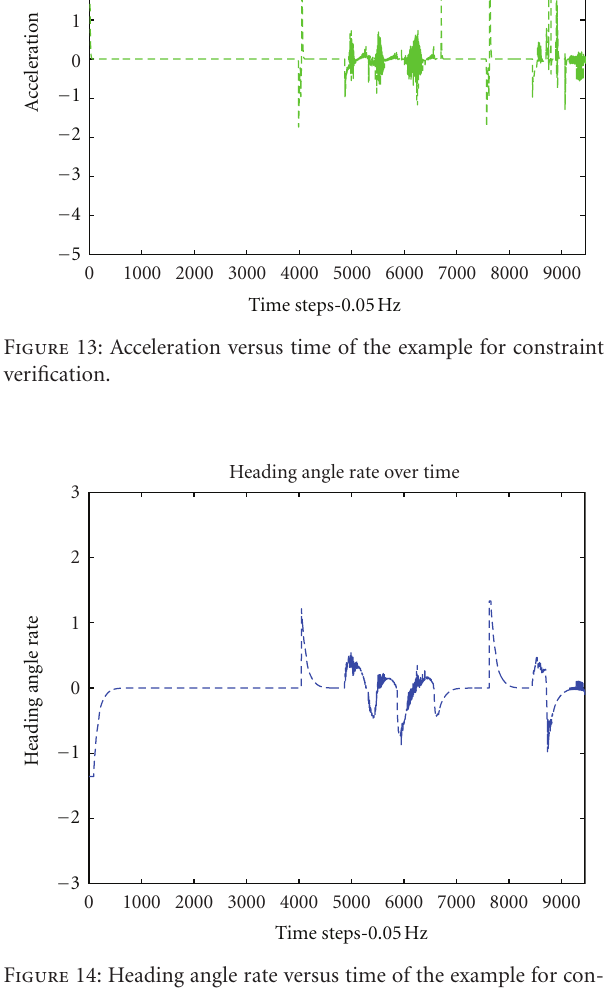
Figure 14: Heading angle rate versus time of the example for con- straint